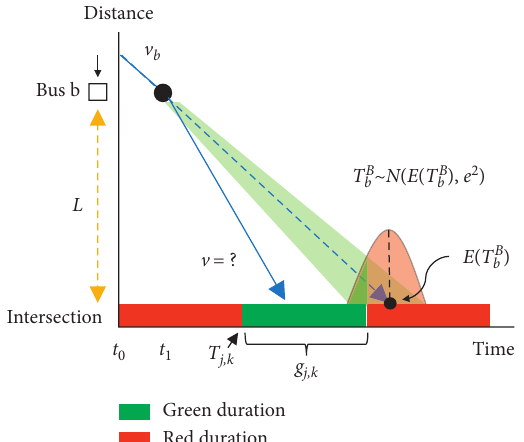
Figure 8: Illustration of passing probability